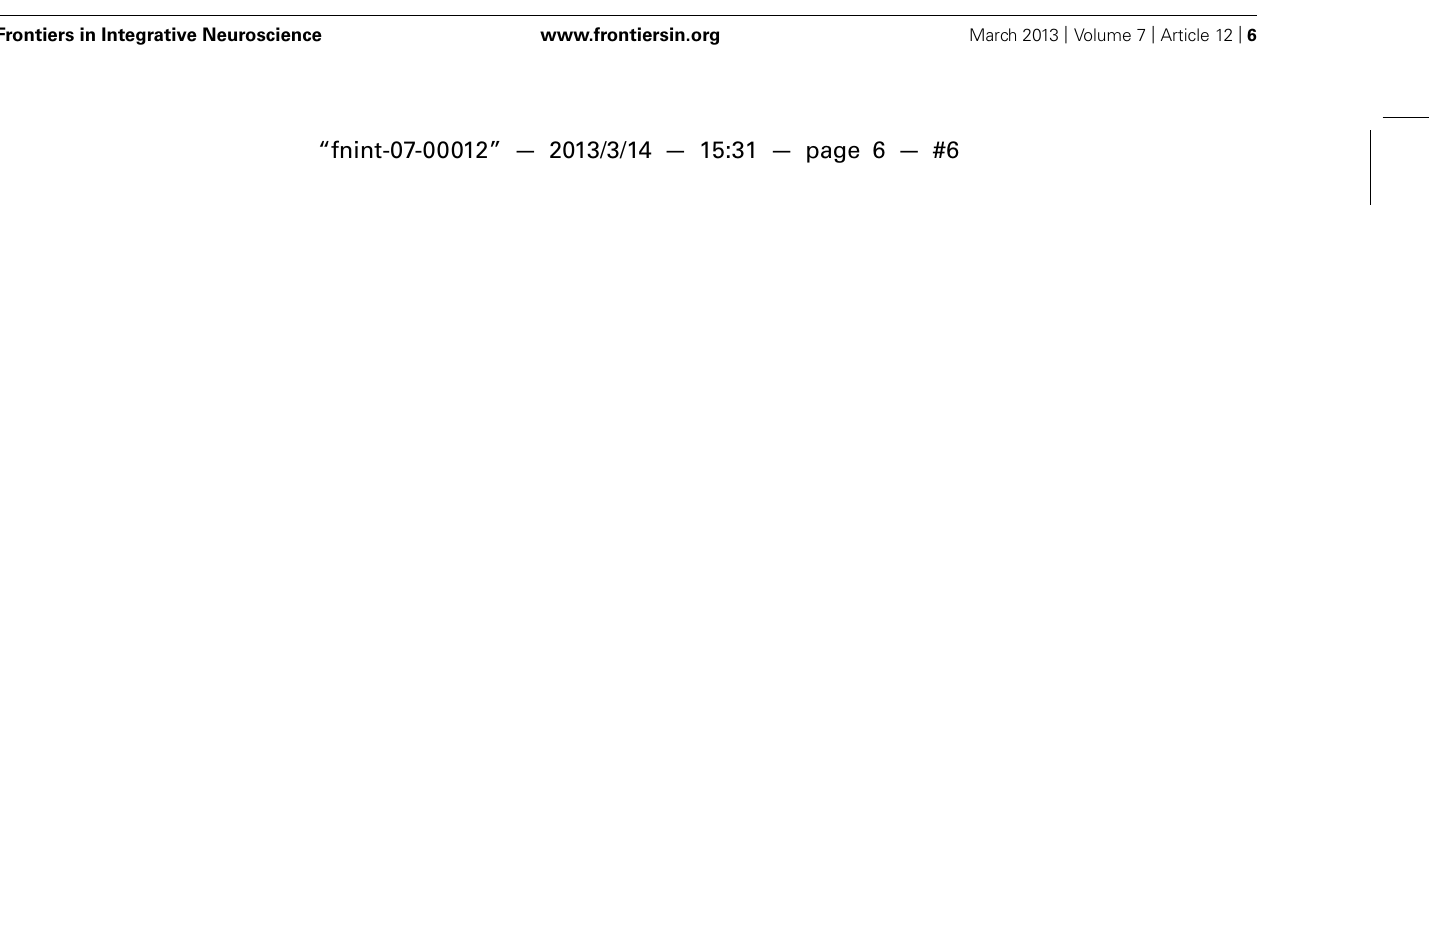
evoked from the dentate gyrus during (i) control LTP and (ii) LTP elicited 1 week after a single systemic vehicle treatment, (iii) LTP induced 1 weeks after vehicle treatment, (iv) LTP elicited 3 weeks after vehicle treatment and (v) LTP induced 4 weeks after vehicle treatment.Vertical scale-bar corresponds to 5 mV, horizontal scale-bar to 10